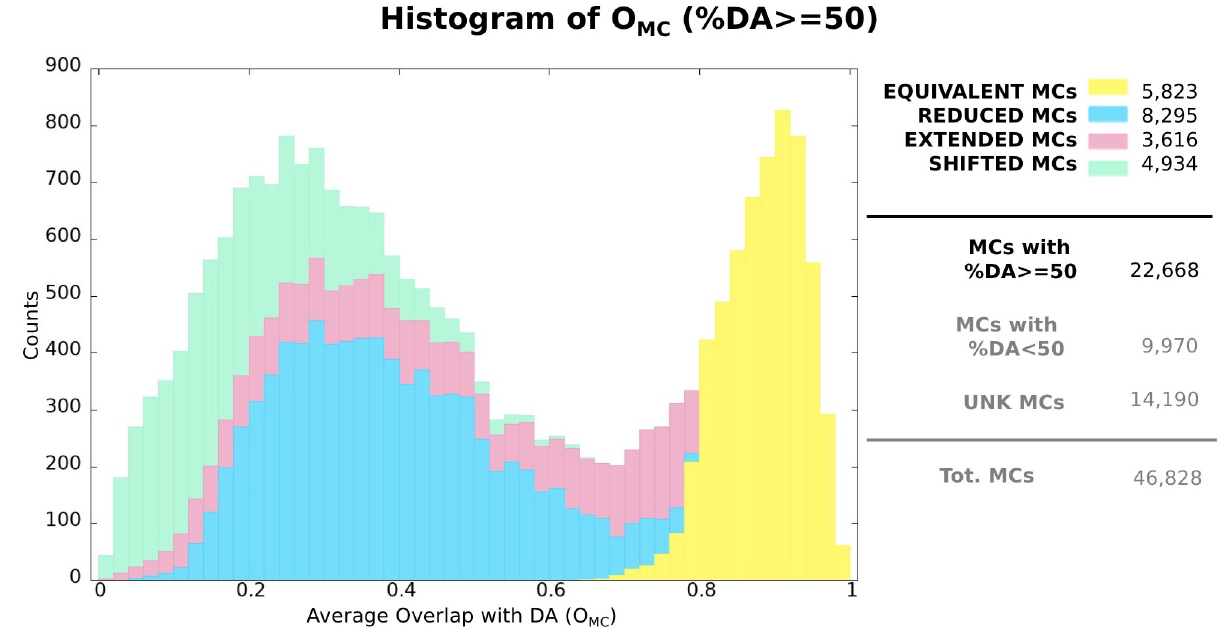
Fig 4. Histogram showing average overlap ( O MC ) between MCs (only those with %DA � 50) and their associated Pfam DAs. Colors reflect the contribution of each MC category to each bin (equivalent, reduced, extended and shifted, see S1(B) Fig and Methods for definitions). The legend on the right side of the histogram reports total counts of MCs in each category and, additionally, total count of MCs with %DA < 50 and total count of unknown MCs.